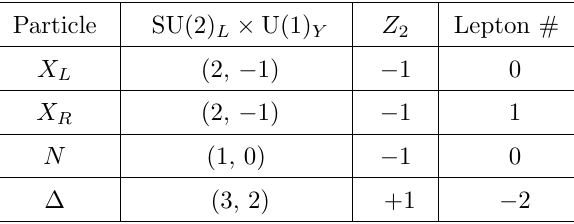
Table 1 . Representations and charge assignments of the introduced